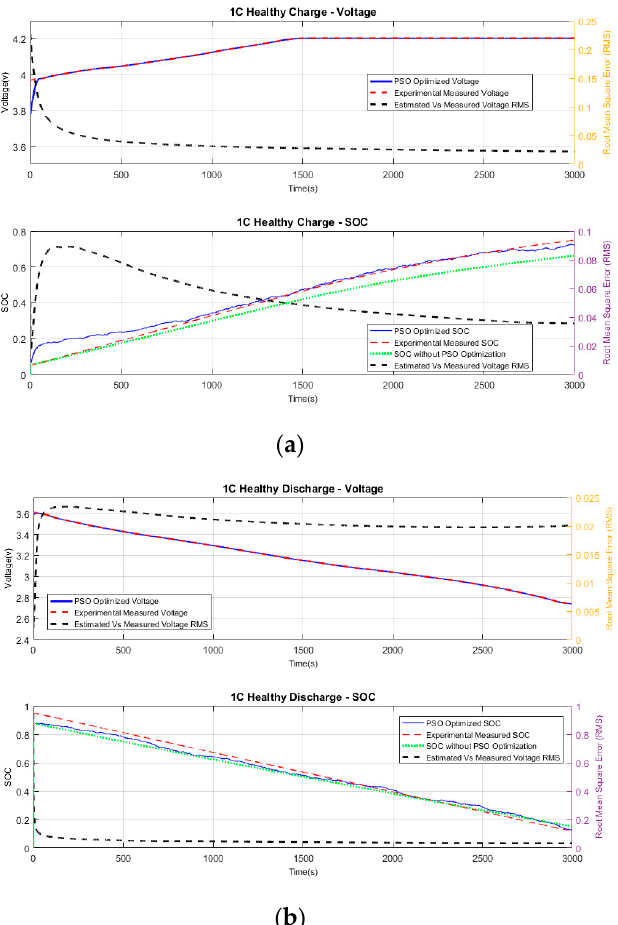
Figure 4. Healthy battery experimental vs. PSO voltage: ( a ) charging; ( b ) discharging.